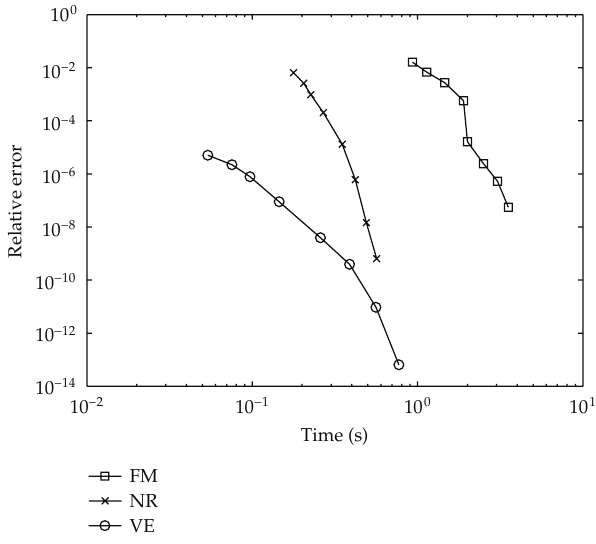
Figure 8: Relative error in P b versus computation